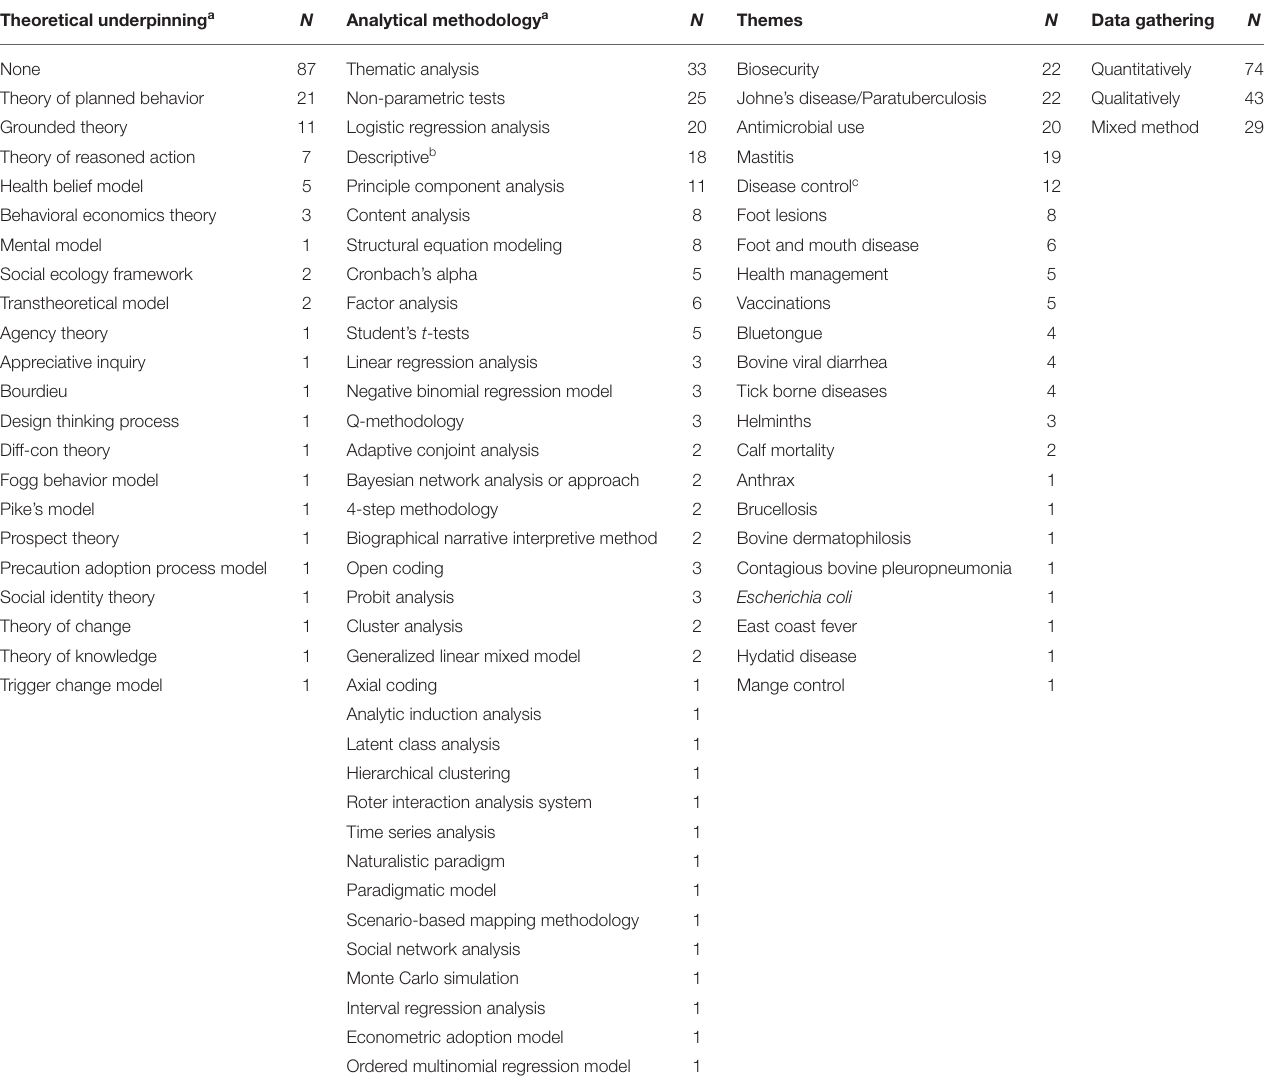
TABLE 2 | Manuscripts ( N = 146) describing farmers’ behavior regarding animal disease prevention and control. Theoretical underpinning